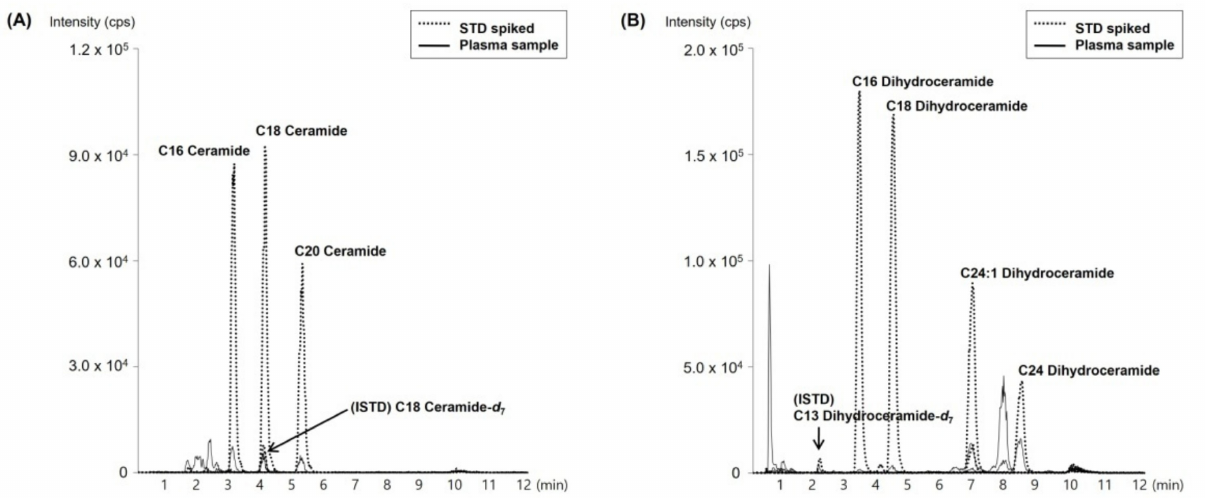
Figure 1. MRM chromatograms of ( A ) Cer-16, Cer-18, and Cer-20, and ( B ) DhCer-16, DhCer-18, DhCer-24, and DhCer-24:1 spiked at 50 ng/mL in 4% BSA with control human plasma. The STD and ISTD indicate the standard and internal standard, respectively. Cer-18- d 7 and DhCer-13- d 7 were used as ISTDs. Table 2. The levels of ceramides and dihydroceramides in control and MetS groups.